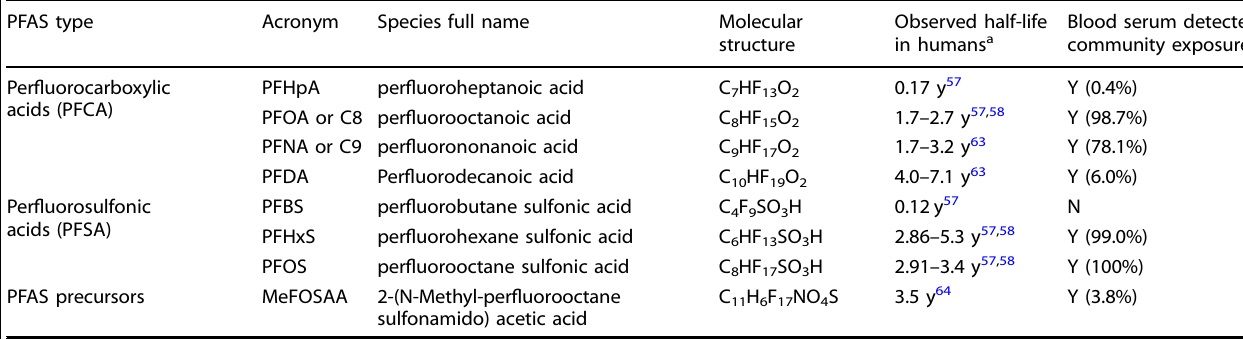
Table 3. PFAS terminology and species